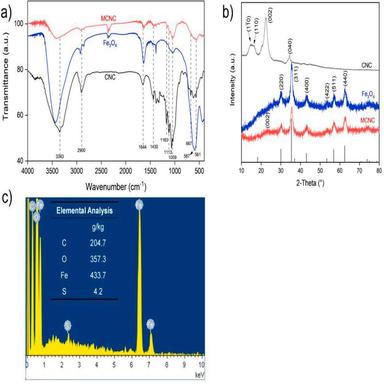
Chemical characterization of CNC, Fe3O4 and MCNC. a) FT-IR spectra; b) XRD patterns and c) EDS spectrum of MCNC and elemental analysis. CNC, cellulose nanocrystals; MCNC, magnetic cellulose nanocrystals; FT-IR, Fourier transform infrared spectroscopy; XRD, X-ray diffraction; EDS, energy dispersion spectrum.